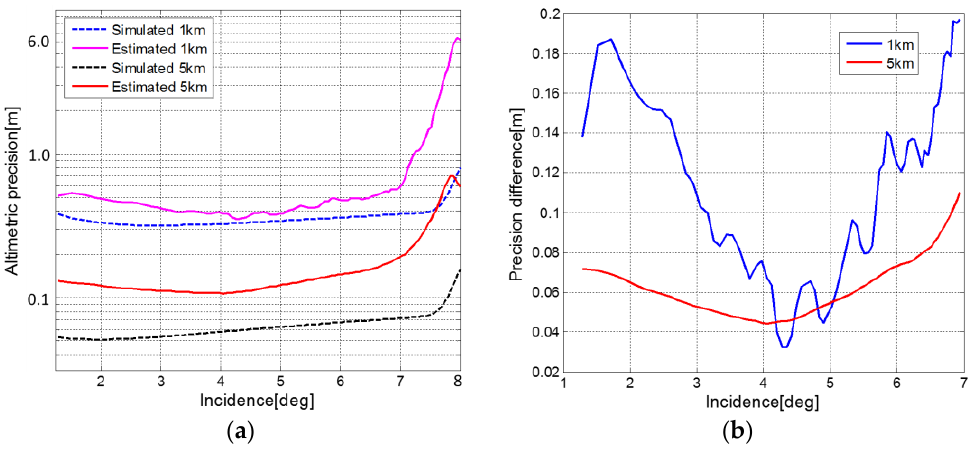
Figure 9. ( a ) Altimetric precision of the estimated and simulated results and ( b ) precision difference between the estimated and simulated results on a 1-km and 5-km grid, respectively.